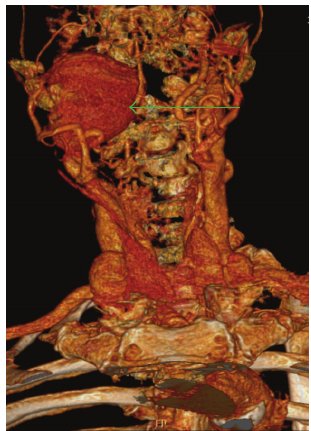
Figure 2: Digital reconstruction of Computed Tomography: extra- cranial aneurysm of right internal carotid artery